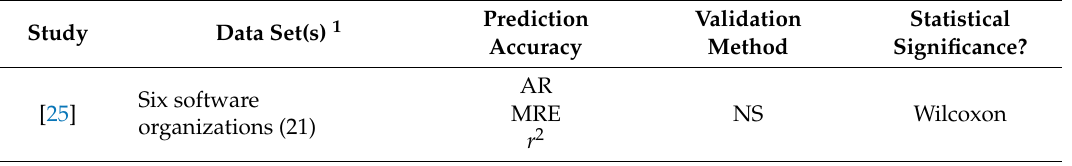
Table 1. Studies on SDEP based on PSO (AR: absolute residual, BRE: mean balanced relative error, IBRE: inverted balanced relative error, LSD: logarithmic standard deviation, LOOCV: Leave-one-out